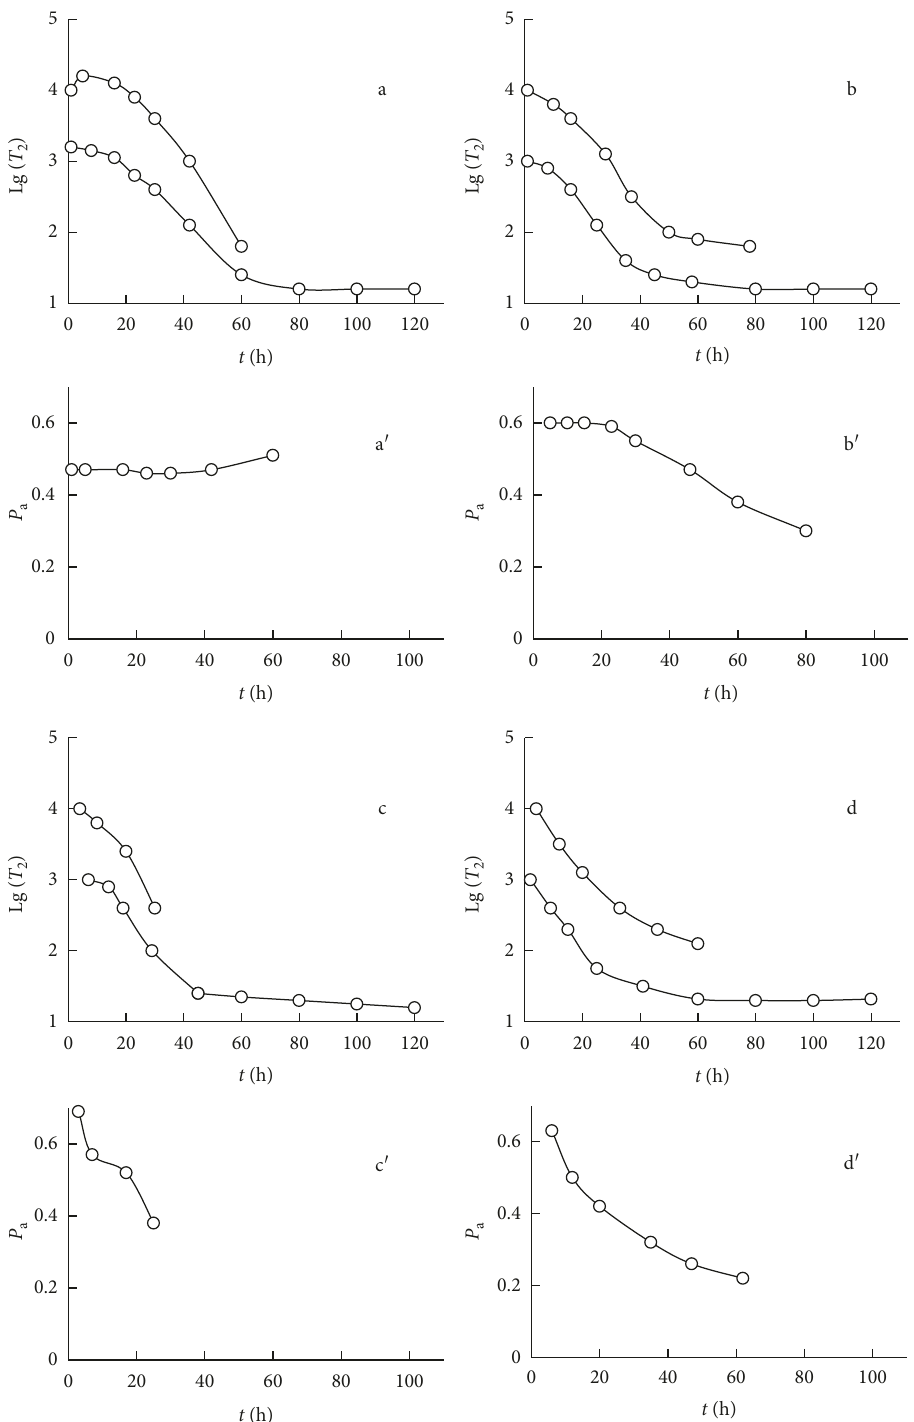
Figure 4: Change in the transverse relaxation times (a–d) and the protons population of the mobile “phase” (a–d) during the curing of ED- 20+DCC/DEG-1 +DETA with the content of DCC/DEG-1: 0% (a,